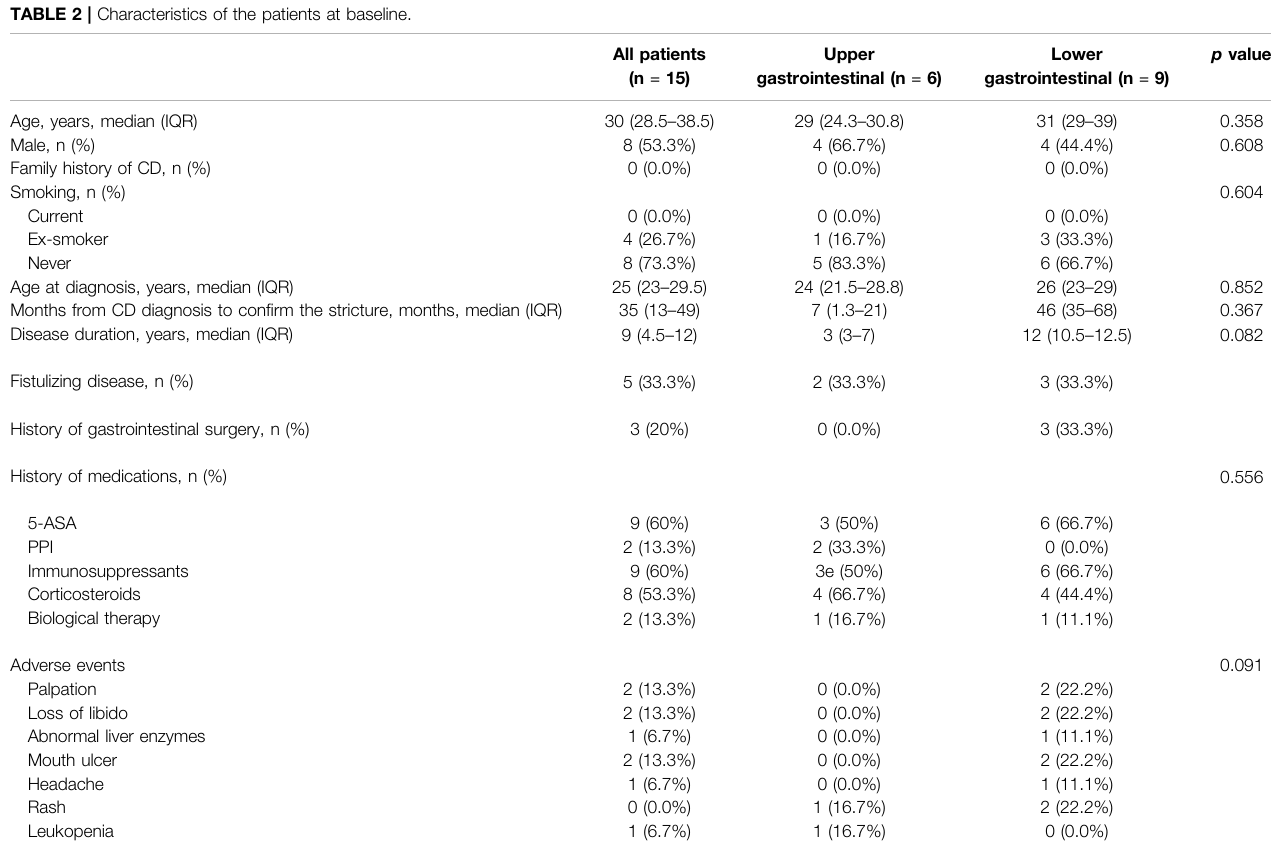
TABLE 2 | Characteristics of the patients at